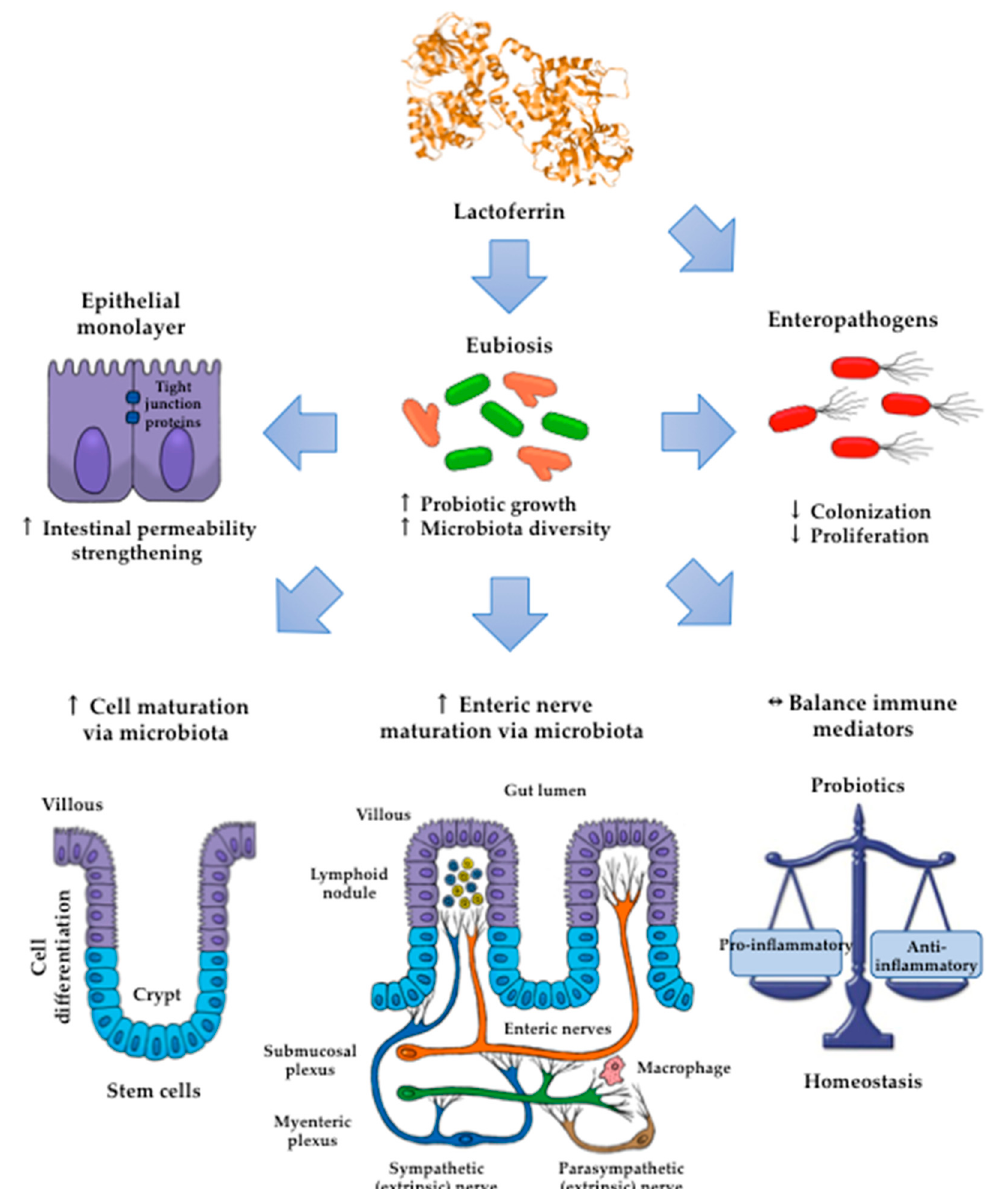
Figure 3. The impact of Lf on the promotion of the growth and diversity of intestinal microbiota may entail (i) strengthening of the permeability of the epithelial cell monolayer; (ii) favoring of the microbial antagonism that discourages the colonization and proliferation of enteric pathogens, enhancing the growth and maturation of (iii) cell-monolayer components and (iv) gut nerve fibers; and (v) providing signals to balance the anti- and proinflammatory responses resulting in homeostasis.